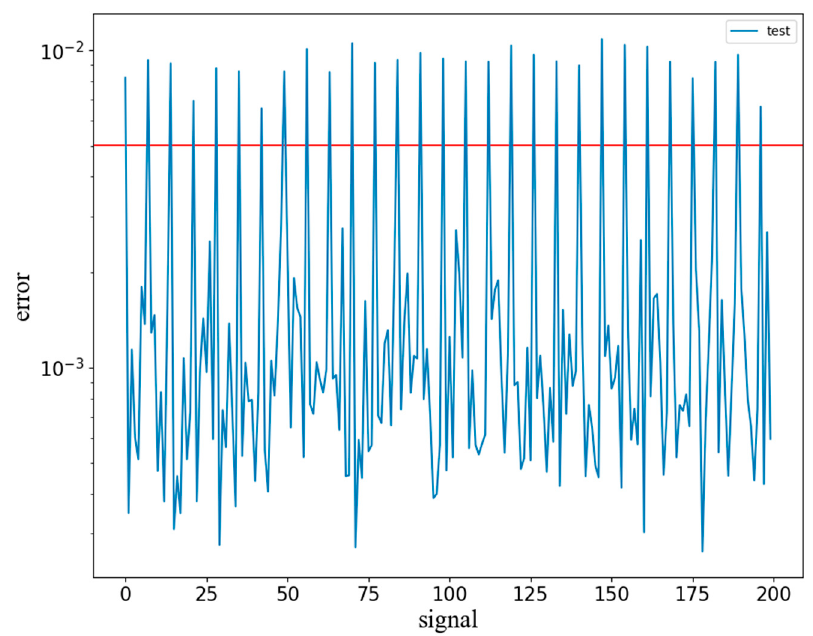
Figure 8. Abnormal Figure 8. Abnormal judgment.